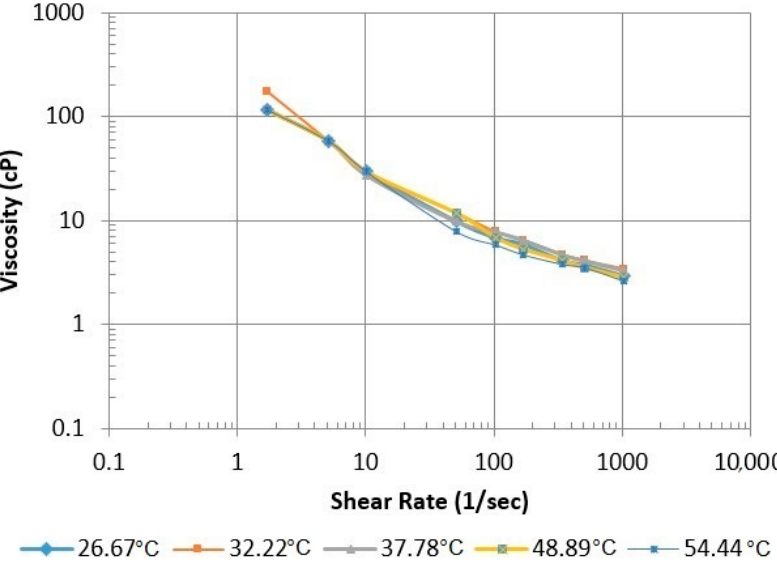
Figure 9. Effects of temperature on the viscosity of the SP and acetone mixture.